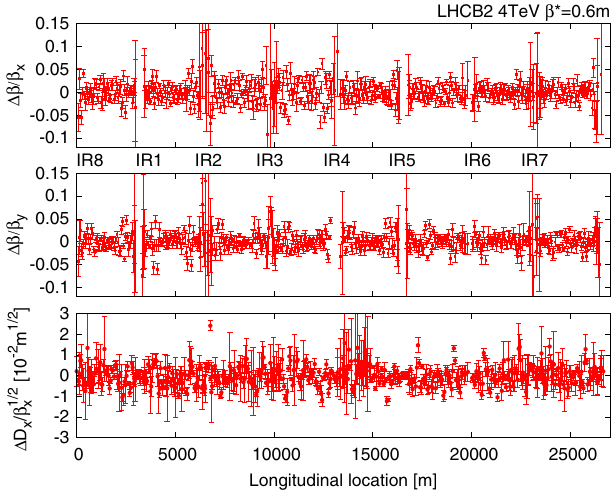
FIG. 8. Beam 2 (cid:1) beating and normalized dispersion beating after global correction at (cid:1) (cid:1) ¼ 0 : 6 m than in the previous year. Figures 7 and 8 show the un- precedented low (cid:1) beating and normalized dispersion beating achieved after the global corrections. Figure 9 shows the evolution of the (cid:1) beating along the squeeze after local and global corrections. This figure is to be compared to Fig. 4. Table III shows the evolution of the peak and rms values during the correction process. The normalized dispersion was within tolerance already after the local corrections. The global corrections further re- duced its deviation by a factor of 4 for beam 1. Similarly the (cid:1) beating is already within specifications after the local corrections. After global corrections the record peak (cid:1) beating of ð 7 (cid:4) 4 Þ % is achieved for the first time in a high energy hadron collider. This value matches the current record for high energy lepton colliders held by CESR.